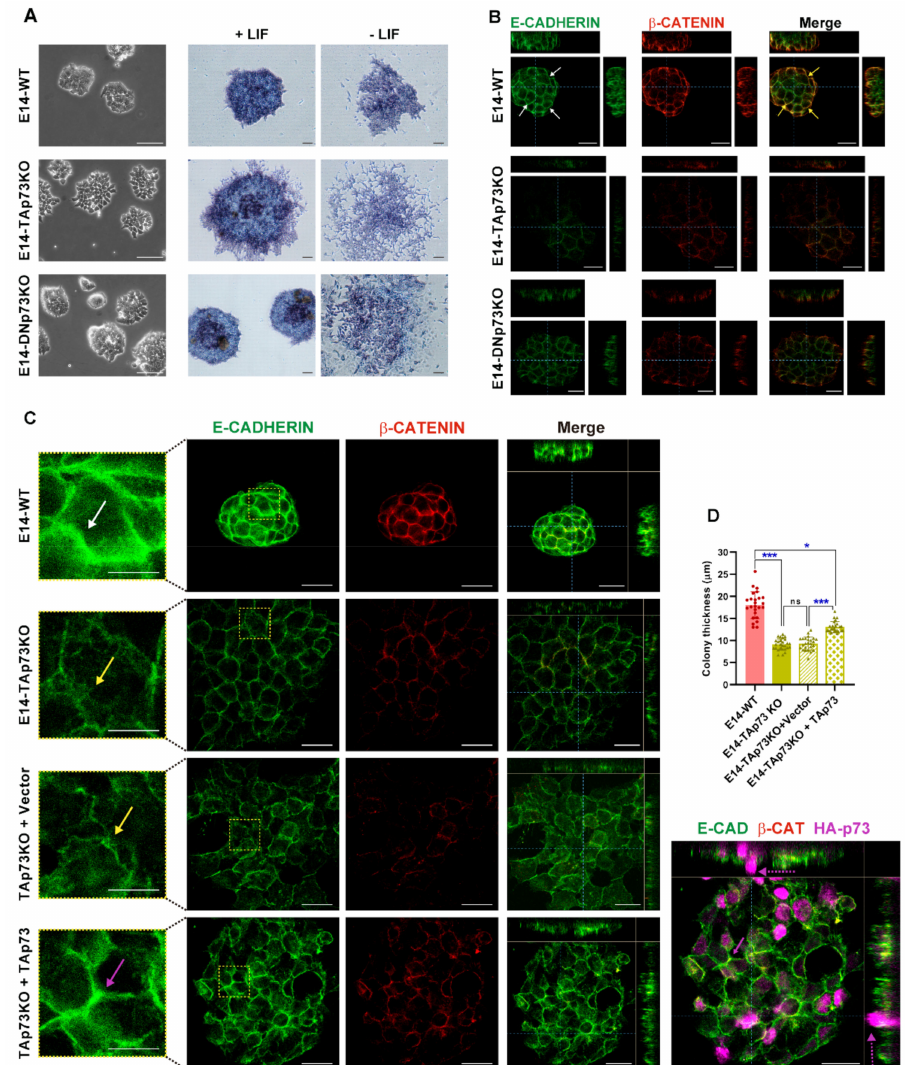
Figure 6. TAp73 is required for the establishment of appropriate adherens junctions (AJs) and its absence results in the formation of mESC colonies with a “primed” phenotype. ( A ) Representative images showing characteristic colony morphology of WT and knockout E14 cells seeded under stemness conditions and images of alkaline phosphatase activity for colonies grown in the presence or absence of LIF. Scale bar: 100 µ m. ( B , C ) Analysis of AJs and colony thickness by confocal microscopy orthogonal projections of three-dimensional reconstruction images in the indicated genotypes ( B ) or after TAp73 ectopic expression in E14-TAp73KO cells ( C ). Cells were immunostained with anti- β -catenin (red) and anti-E-cadherin (green) antibodies. Scale bar: 20 µ m. White arrows indicate continuous and tight AJ ( B , C ), yellow arrows pleated and broken up AJ ( C ) and pink and dotted arrows indicate recovered AJ and second layer of cells after TAp73KO re-expression, respectively. The insert represents a magnification of the indicated area (RED square). ( D ) Quantification of colony thickness using orthogonal projections from Z-stacks of confocal microscopy images. * p -value < 0.05, *** p -value <